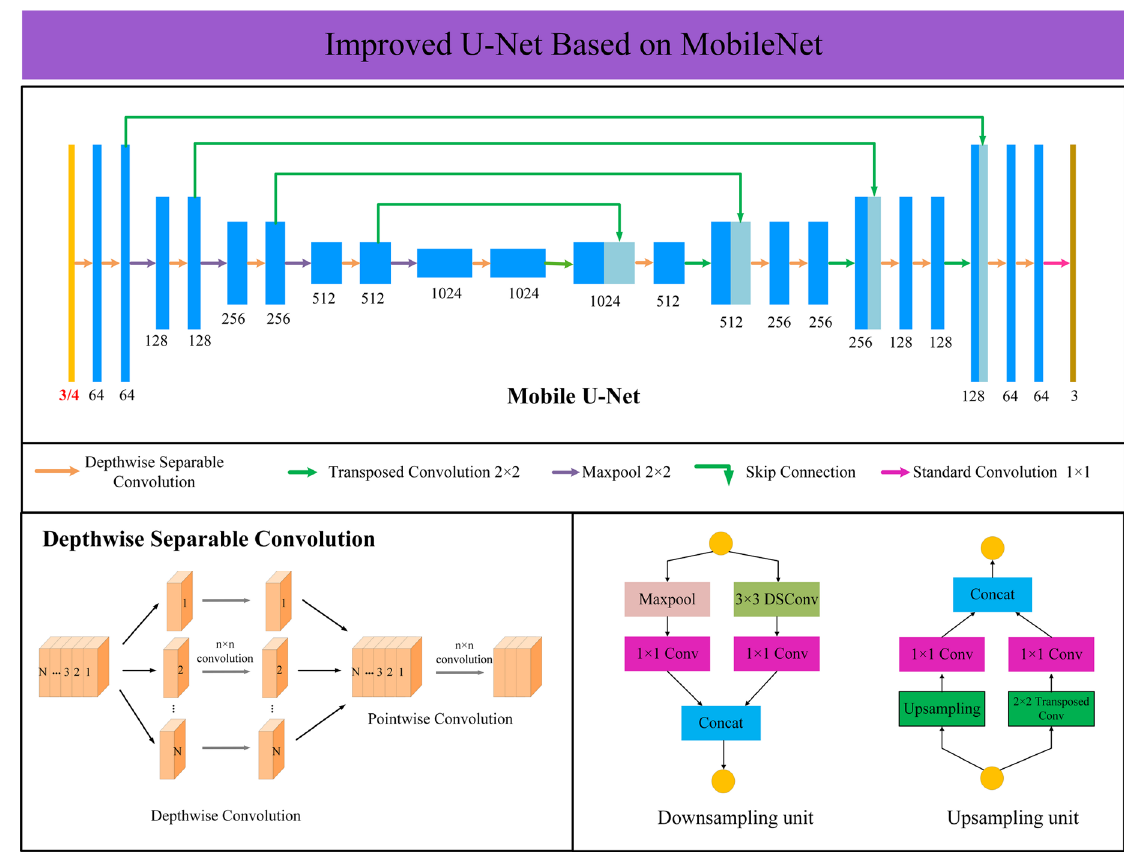
Figure 3. The structure of the Mobile U-Net model. (3/4 means that the parameter is set to 3 for RGB as input data and the parameter is set to 4 for four-channel image as